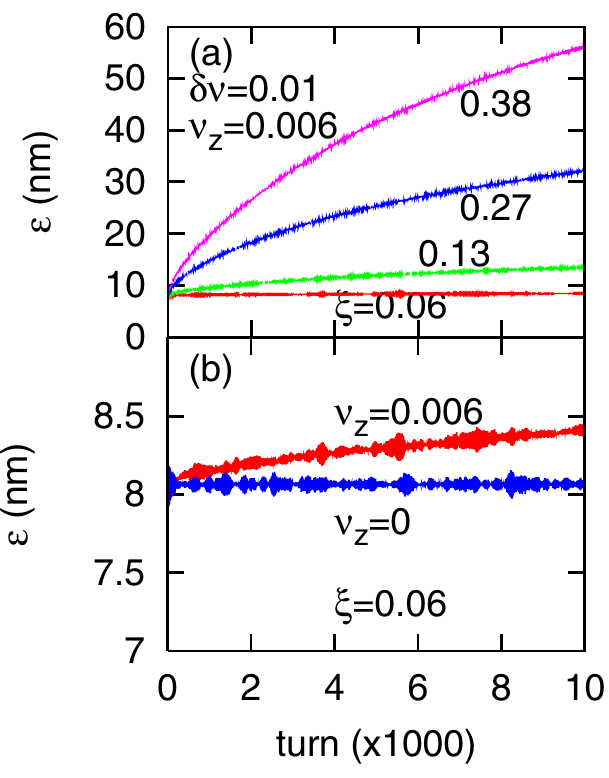
FIG. 17. (Color) Emittance growth for system with 4 degrees of (cid:4) (cid:5) (cid:3) 0 : 2851 ; 0 : 2951 ; 0 : 006 (cid:4) . The ; (cid:8) ; (cid:8) freedom, where (cid:3) (cid:8) x y z growths for (cid:12) (cid:5) 0 : 06 – 0 : 38 are depicted in plot (a), and that for (cid:12) (cid:5) 0 : 06 is depicted in plot (b) with a fine